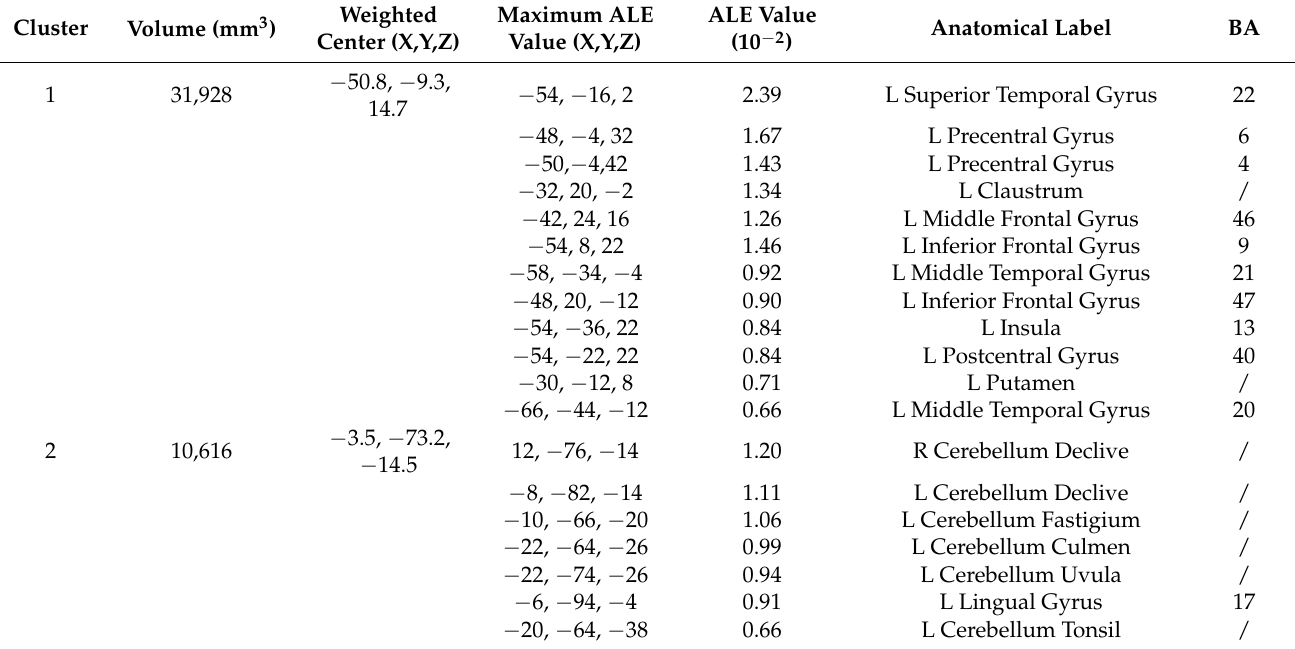
Table 2. PWNS clusters found by ALE analysis. L: left; R: right; BA: Brodmann area.